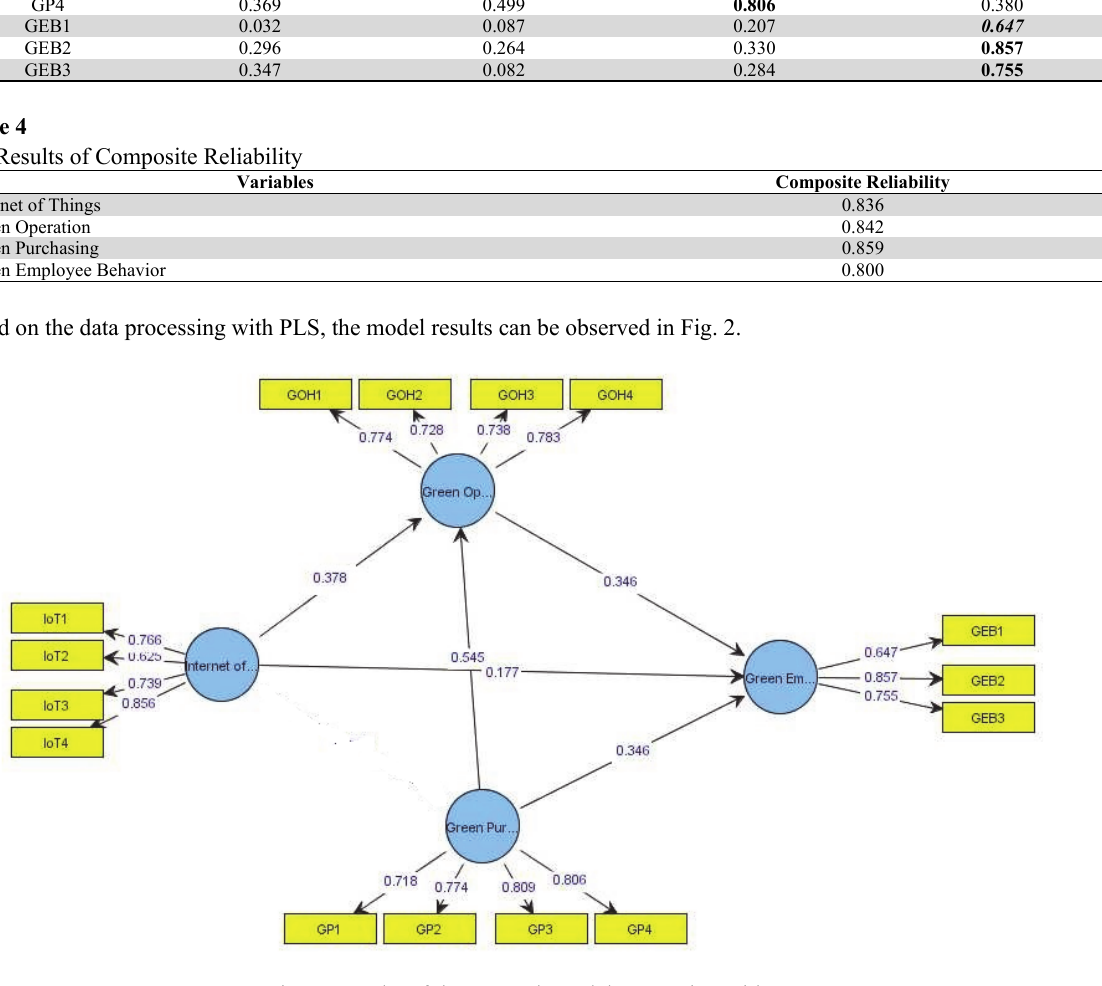
Fig. 2. Results of the research model processing with PLS